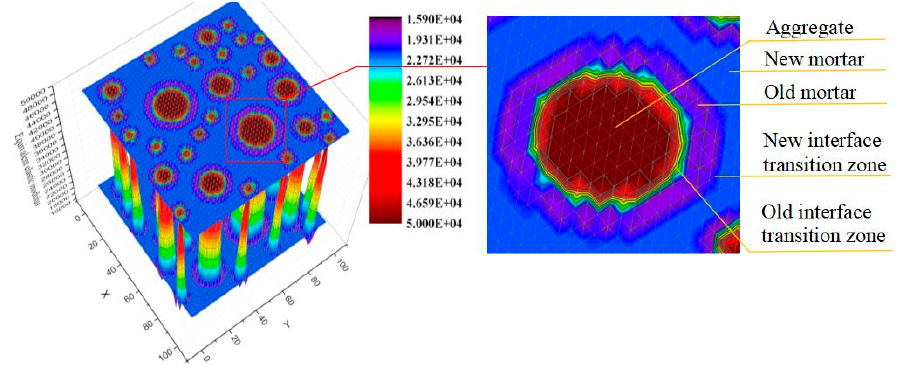
Figure 5. Equivalent elastic modulus distribution.